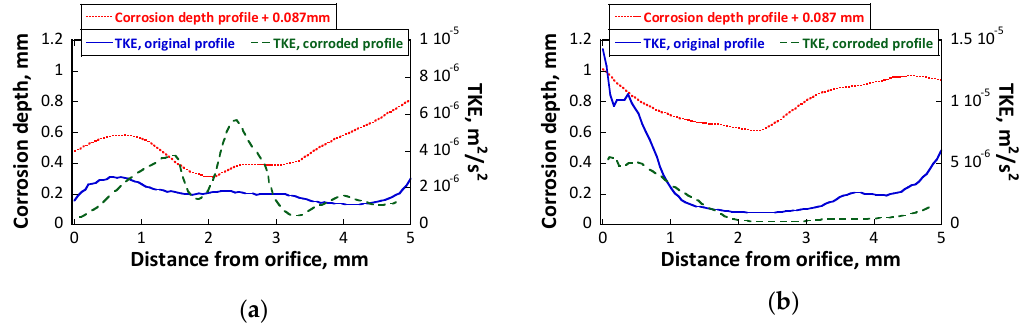
Figure 13. Effects of the corroded surface on TKE in the near-wall region at the two orifices. The utilized corrosion depth profile is plotted together for comparison. ( a ) Inlet orifice; ( b ) Outlet orifice.